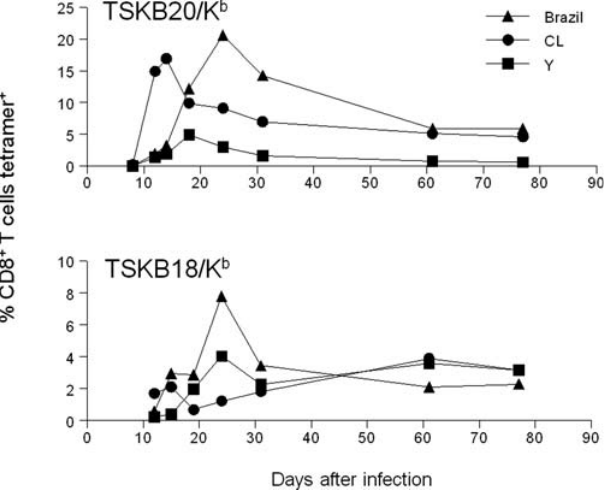
Figure 5. Parasite Strain–Dependent Dominance Patterns in T. cruzi – Infected Mice B6 mice were infected with 1,000 Brazil, 1,000 Y, or 10,000 CL strain T. cruzi and stained with TSKB20/K b (top) or TSKB18/K b (bottom) tetramers as described in Materials and Methods. Data shown are a combination of two separate experiments with three or four mice per group